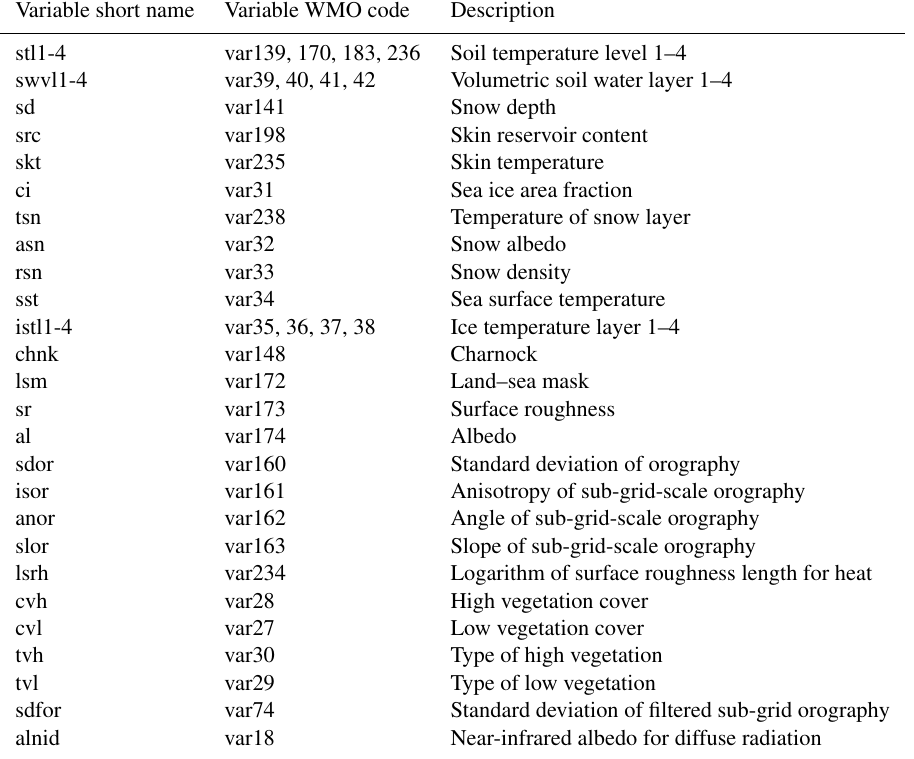
Table A1. Surface-level variables on a Gaussian reduced grid in the ICMGGoifsINIT file. WMO stands for World Meteorological Organiza- tion.